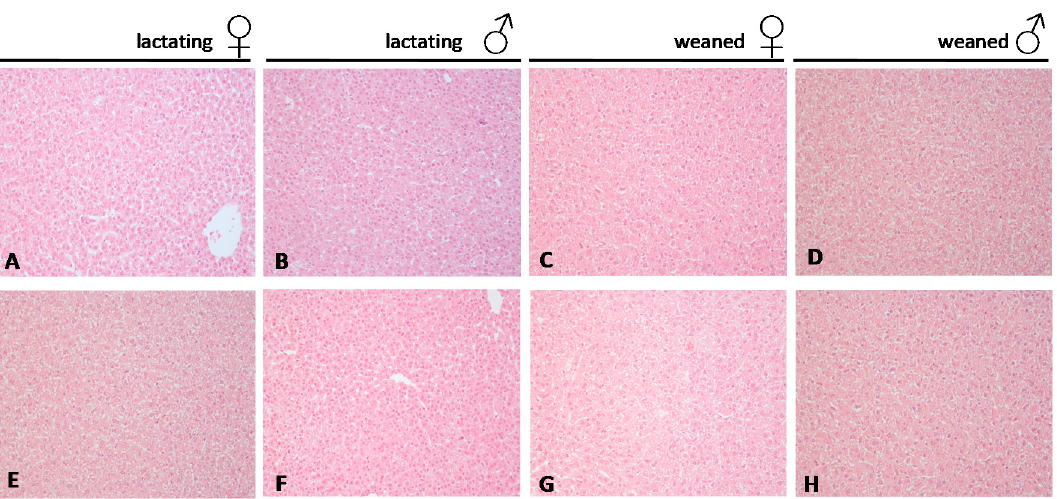
Figure 3. Representative haematoxylin and eosin–stained sections from liver tissue of rats. ( A – D ) controls, ( E – H ) BPA treated. (original magnification 20×). Females ♀ , males ♂ . Table 2. Histological features of liver from control and BPA-treated rats at 10–17 PND and 45–60 PND.